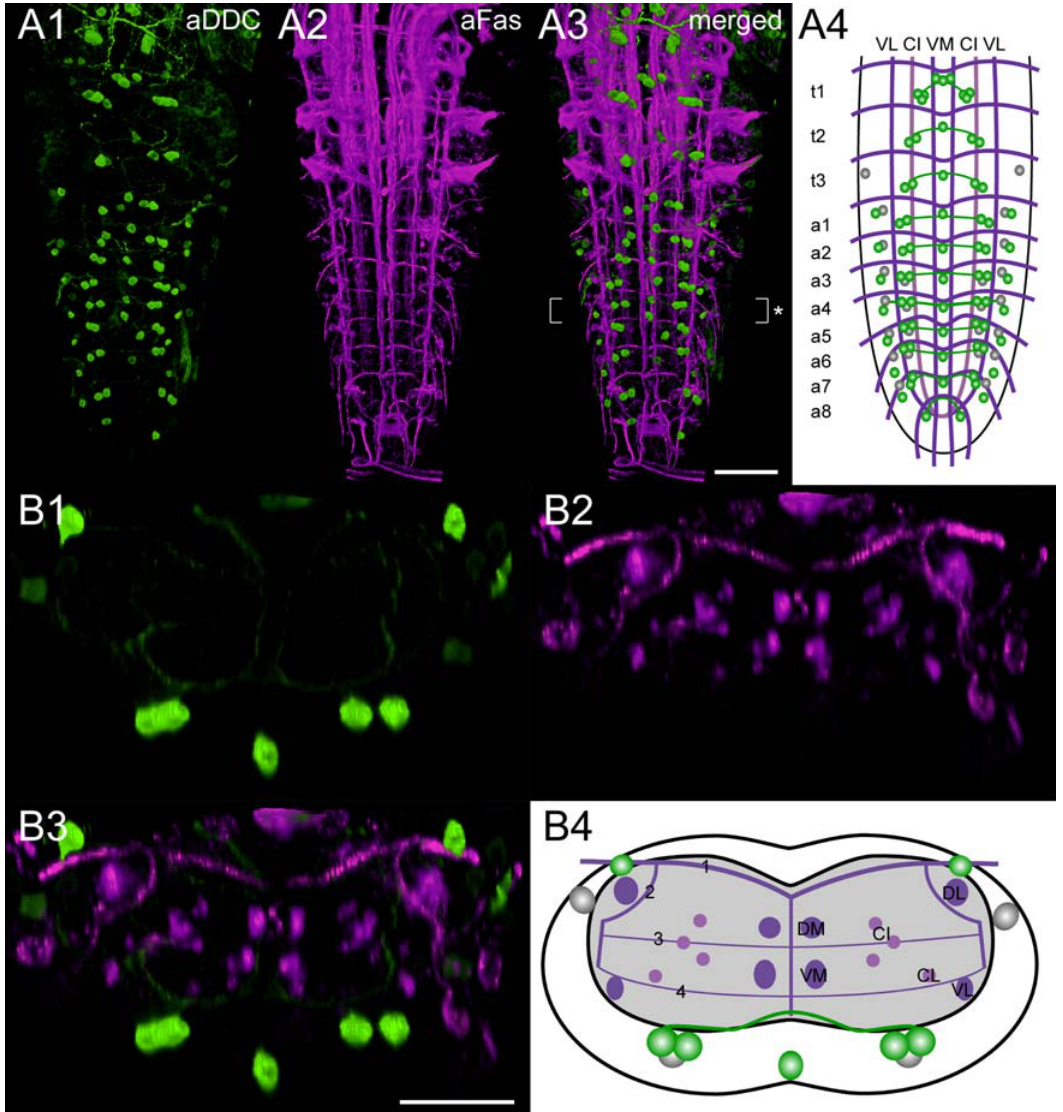
Figure 7. Mapping of DDC-immunoreactive neurons. A1) Ventral view of 3D image stacks showing volume-rendered DDC-immunoreactive neurons (green) and A2) Fas2-positive tracts (magenta) in a larval VG. The merged image (A3) served for an idealized schematic representation of DDC- immunoreactive neurons in the Fas2 landmark system (A4). B1-3) Corresponding transversal views of the neuromere a4 (* in A3), and B4) the deduced idealized scheme. Besides the aminergic neurons, the DDC antiserum also faintly labeled presumed peptidergic neurons, which are shown in gray in the schemes. Noteworthy, these peptidergic neurons are also present in the Ddc-gal4 expression pattern (see Fig. 6). Scale bars: 50 m m in A), 25 m m in B).